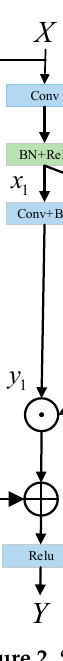
Figure 2. Structural design of residual correction branch (RCB).